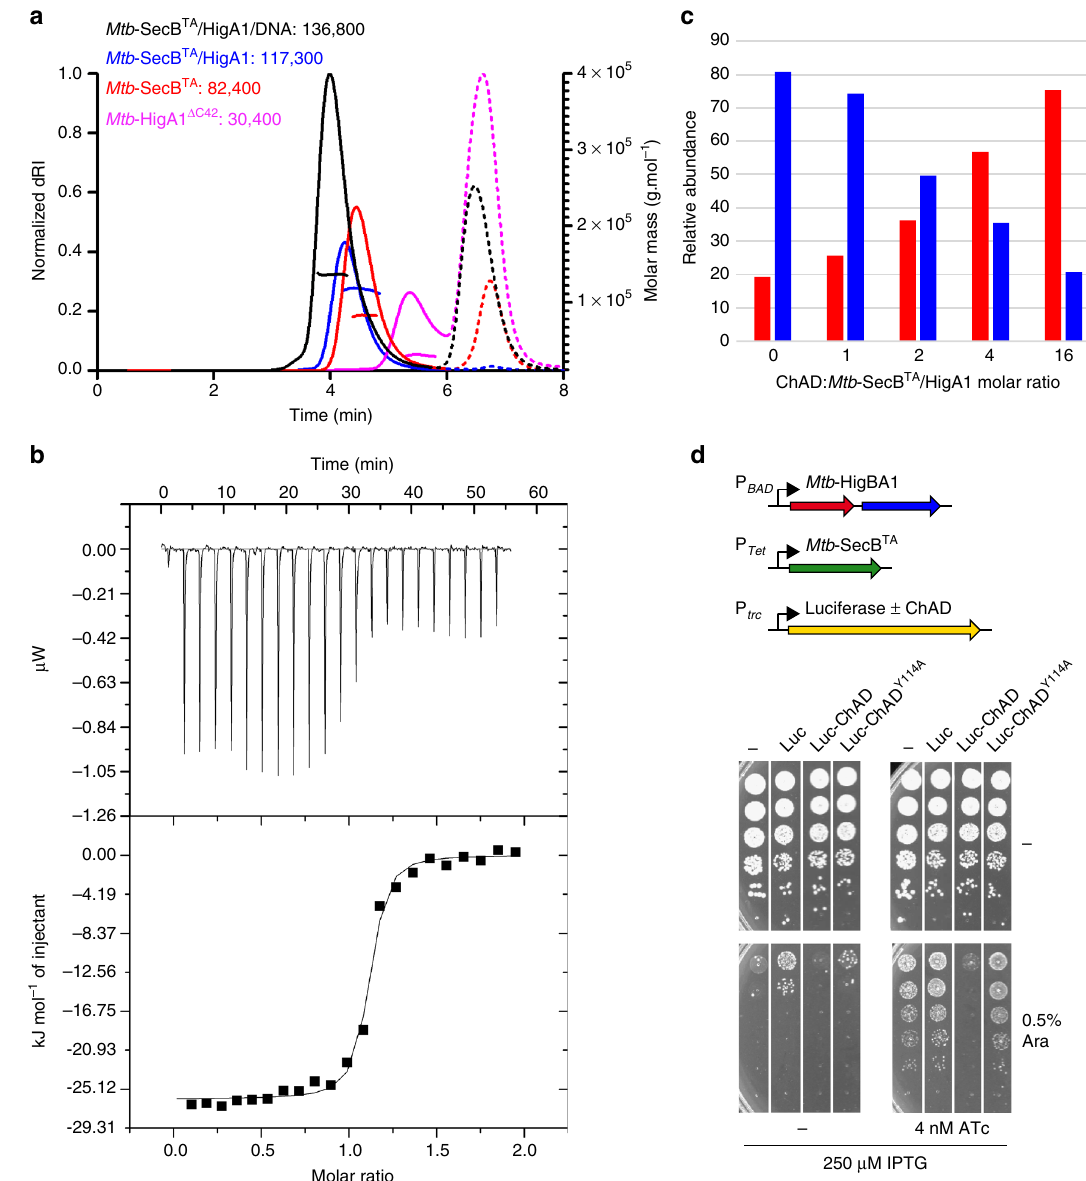
Fig. 5 Characterization of full-length Mtb -SecB TA /HigA1 chaperone/antitoxin complex. a SEC-MALS analysis. Continuous and dashed lines represent the variation of refractive index against elution time for Mtb -SecB TA (red), Mtb -SecB TA /HigA1 (blue), Mtb -HigA1 Δ C42 (violet), and Mtb -SecB TA /HigA1/dsDNA (black) for protein and salt contributions, respectively. The experimentally measured molar mass distribution (same color code) and deduced mean molar mass (in g mol − 1 ) are indicated for each elution peak. Calculated molecular masses of proteins and protein complexes used for experiments (in daltons): Mtb -SecB TA tetramer, 81,552; Mtb -SecB TA /HigA1 hetero-hexamer, 115,068; Mtb -HigA1 Δ C42 dimer, 27,994; Mtb -SecB TA /HigA1/dsDNA, 138,420. b ITC pro fi le of 38-bp dsDNA titrated into Mtb -SecB TA /HigA1 (upper and lower parts represent raw and integrated binding heats, respectively). c Native MS- derived relative abundance of Mtb -SecB TA /HigA1 (blue bars) and Mtb -SecB TA (red bars) obtained upon titration of Mtb -SecB TA /HigA1 with 0, 1, 2, 4, 16 molar equivalents of ChAD. d Overexpression of luciferase-ChAD chimera activates Mtb -HigB1. E . coli WPtet57 strain expressing chromosomally encoded Mtb -SecB TA under the control of an anhydrotetracycline inducible promoter was co-transformed with pC6- Mtb -HigBA1 and the pSE380-based vector ( − ), luciferase (Luc), or the Luc- Mtb -ChAD and Luc- Mtb -ChAD Y114A chimeras. Transformants were grown to mid-log phase, serially diluted and spotted on LB ampicillin chloramphenicol agar plates without or with IPTG (to express Luc and Luc chimeras), arabinose (to express Mtb -HigBA1), and anhydrotetracycline (to express Mtb -SecB TA ) inducers as indicated. Plates were incubated overnight at 37 demonstrated that Mtb -SecB TA /HigA1 forms a single stable promoter 41 . We also used native MS to analyze Mtb -SecB TA / molecular species in the presence of DNA, most likely HigA1 in complex with its speci fi c DNA target and observed that corresponding to 4:2:1 Mtb- SecB TA /HigA1/DNA stoichiometry they indeed form a 4:2:1 complex of molecular weight 138.25 kDa (Supplementary Fig. 9a). In addition, ITC experiments showed (Fig. 5a), with a shift in the hydrodynamic radius from 4.4 to 5.0 that the higB P2 promoter DNA fragment interacts with the nm upon DNA binding. We veri fi ed by SEC-MALS that no hexamer with a high af fi nity (2.2 ± 0.5 × 10 7 M − 1 at 25 °C) interaction occurs between Mtb -SecB TA /HigA1 and a nonspeci fi c dsDNA such as a 16-bp oligonucleotide derived from the RRM1 (Fig. 5b). The ITC-derived thermodynamic parameters indicated